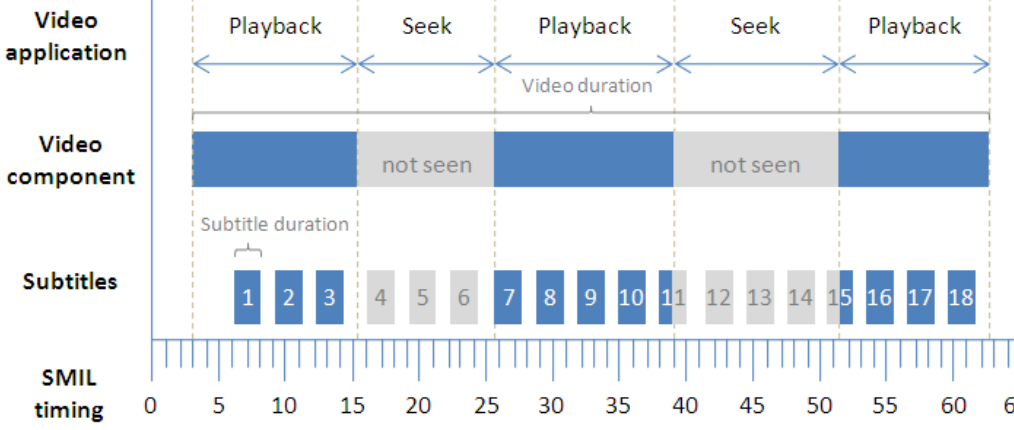
Figure 5. Strip diagram of basic timing support together with two video seek operations.